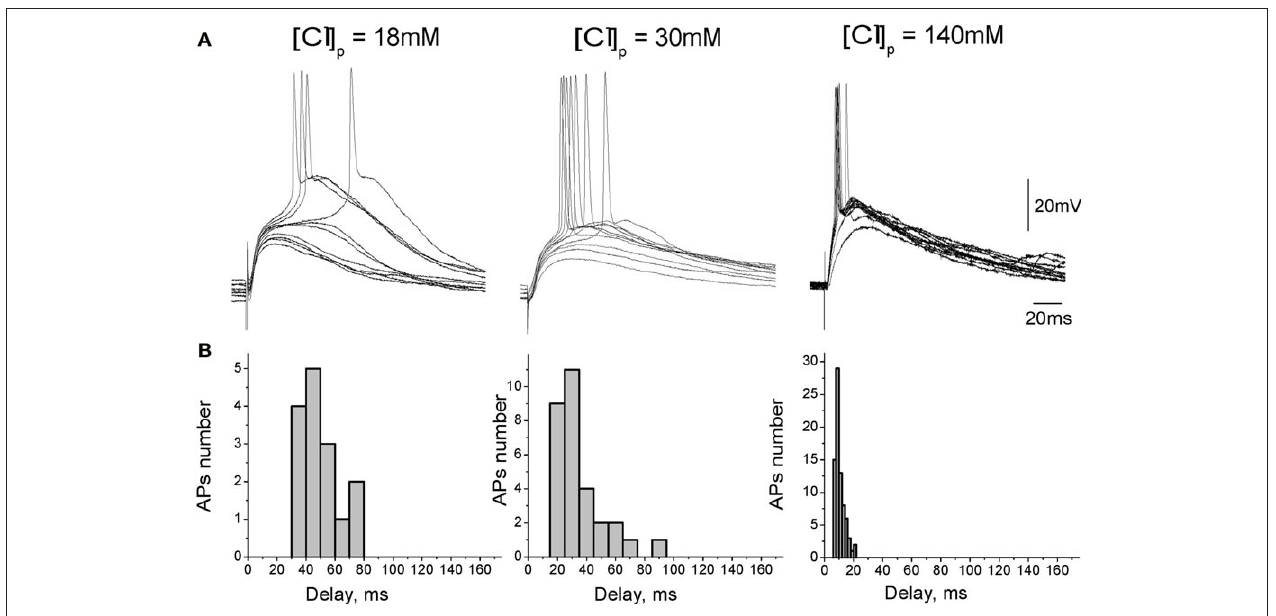
Figure 2 | Dependence of depolarizing gABAergic postsynaptic responses on chloride concentration in the recording pipette. (A) GABA(A) receptor mediated postsynaptic potentials recorded from CA3 pyramidal cells in whole-cell